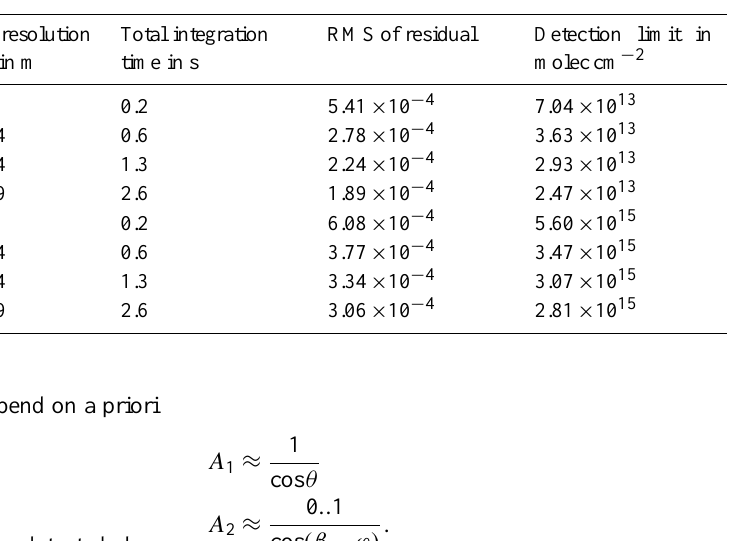
Table 7. Influence of scan binning on the spatial resolution and detection limit of the nadir scanner (whiskbroom). The first value of the binning is the amount of included swaths, while the second value gives the number of co-added scans within each of these swaths. The spatial resolution ( P k × P ⊥ ) is calculated by Eqs. (1) and (2) for average flight conditions ( h a.g.l. = 1500m, v g = 55ms − 1 ). The spectra for determining the detection limits were taken from the same time intervals as the fits shown in Figs. 12 and